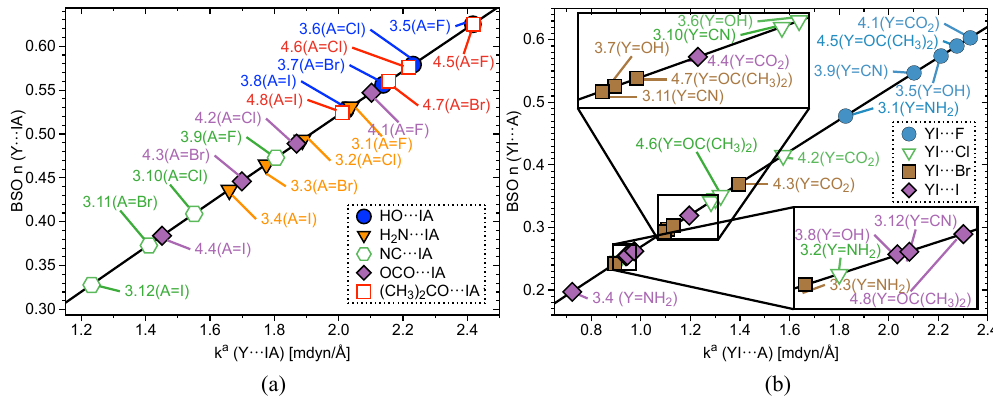
Figure 3. ( a ) BSO n versus for k a of Y · · · IA ( 3.1–4.8 ) ( b ) and BSO n versus k a of YI · · · A for complexes 3.1–4.8 according to eq 2, where A = the axial halogen atom and Y = the non-halogen atom bound axial to I.